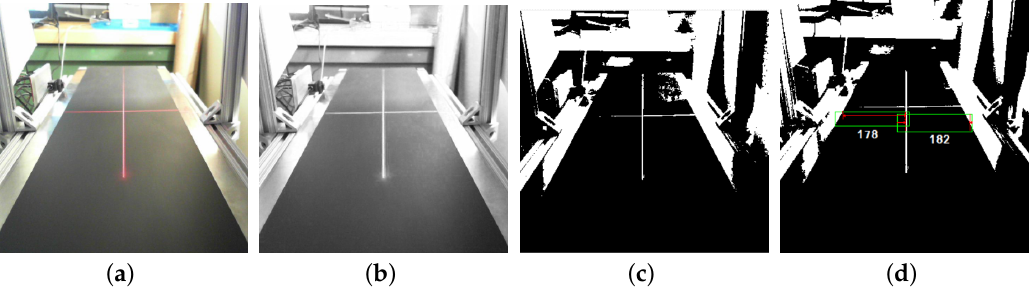
Figure 7. Image processing results using Method 1: ( a ) original image, ( b ) HSV image, ( c ) binary image, ( d ) detection result